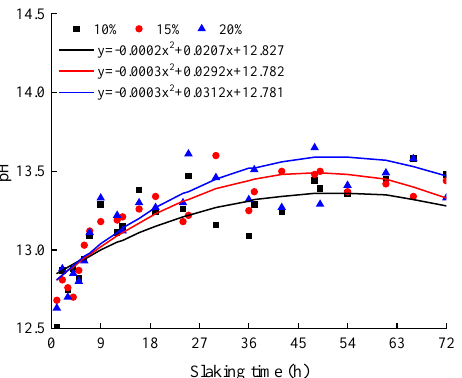
Figure 4. The pH curves of lime soils with different slaking times.